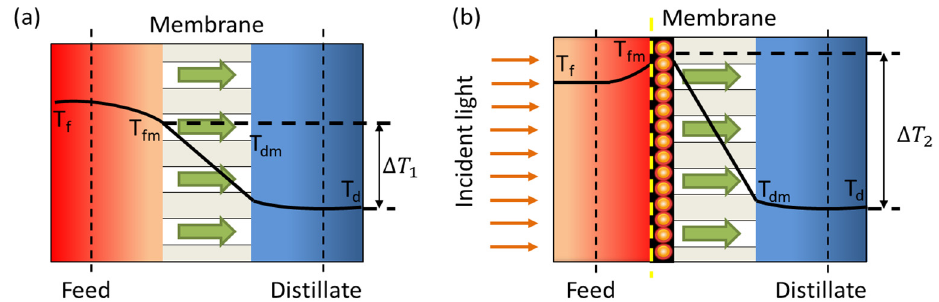
Figure 1. Temperature polarization in ( a ) conventional MD and ( b ) photothermal MD.